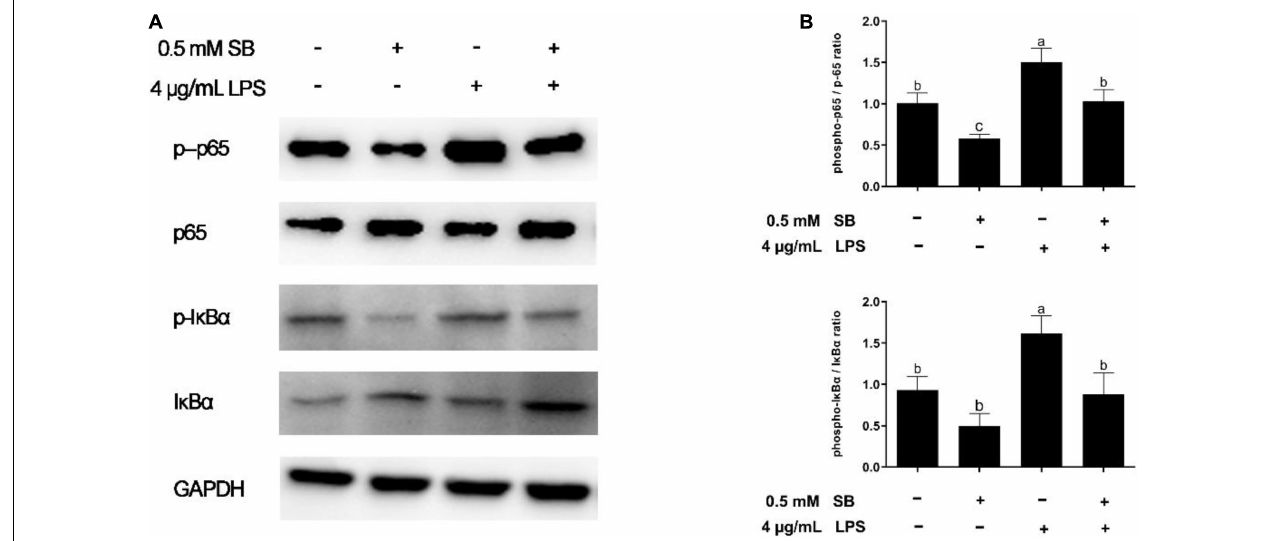
FIGURE 2 | Sodium butyrate (SB) inhibiting the canonical NF- κ B signaling pathway. BRECs were pretreat with SB (0.5 mM) for 18 h, followed by stimulation with LPS for 6 h. Western blotting was performed to determine the phosphorylation levels of I κ B and p65. (A,B) Immunoblotting and acquisition of intensity from the respective blots. The values are shown as mean ± SEM ( n = 3). The letters in superscript indicate that the difference between groups was significant ( P <